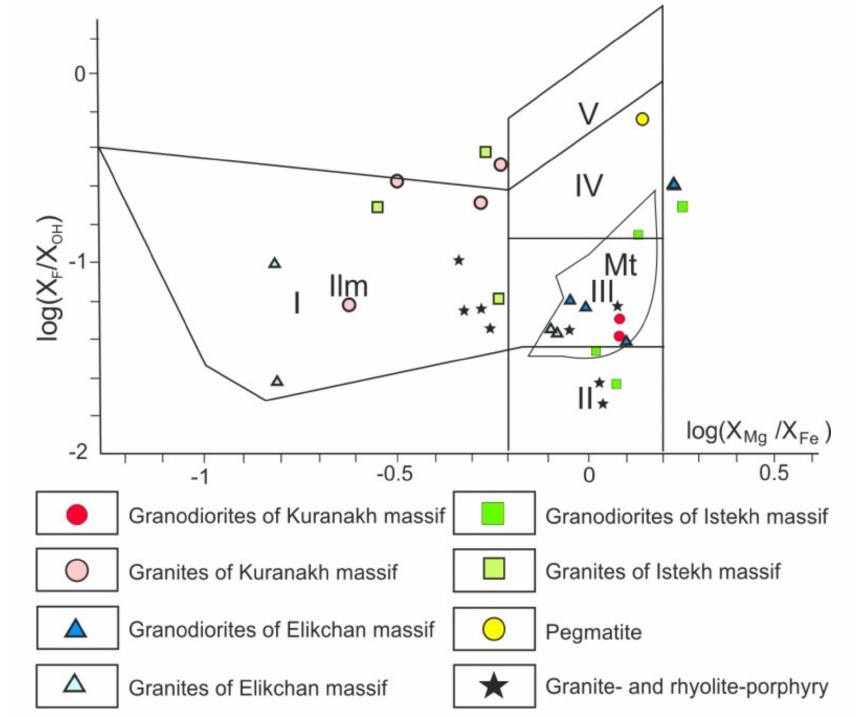
Figure 5. F/OH–Mg/Fe diagram for biotites of magmatic rocks. Fields of biotite derived from melts [69]: I—contaminated and assimilated marine metasediments; II—mantle; III—crust-mantle, IV—mantle-crustal, and V—crustal anatectic.